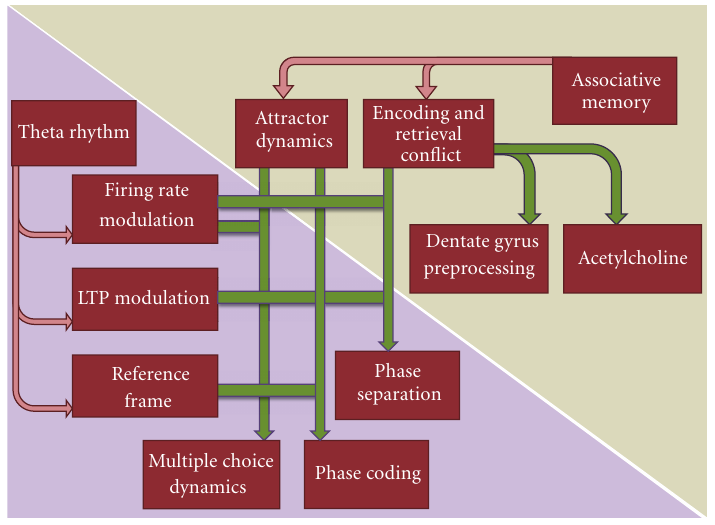
Figure 6: Overview of the theories reviewed here and their conceptual